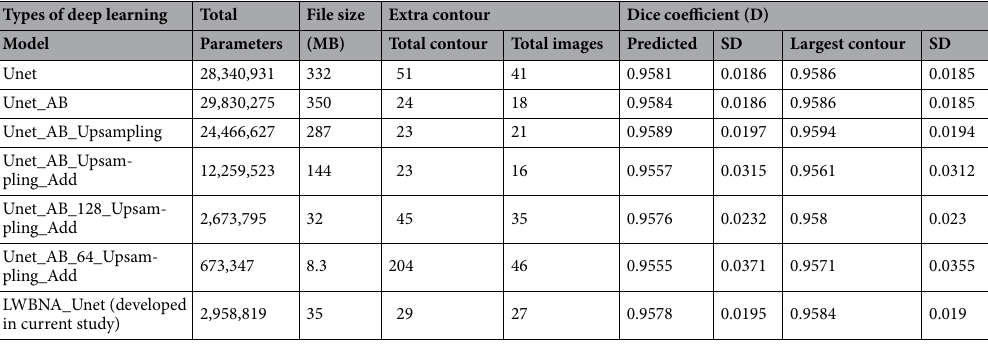
Table 2. Summary of Unet based DL models along with the lightweight model, ‘LWBNA_Unet’ developed in the present study. Performance of the trained DL models was tested on a testing dataset of 145 OCTA images. Dice similarity coefficient (D) was calculated between the manually segmented image, and the image predicted by the DL model. The largest contour D is calculated by selecting the biggest segmented area in the predicted image (when multiple FAZ region exist). SD is the standard deviation. All the models were trained for fixed number of epochs (500). AB Attention block, Unet and Unet_AB are standard DL models without and with attention block. The numbers 128 or 64 mean the model has fixed channels/filters (128 or 64) in each 2D convolution layer. Unet or Unet_AB uses transpose convolution and concatenate instead of upsampling and add layers.